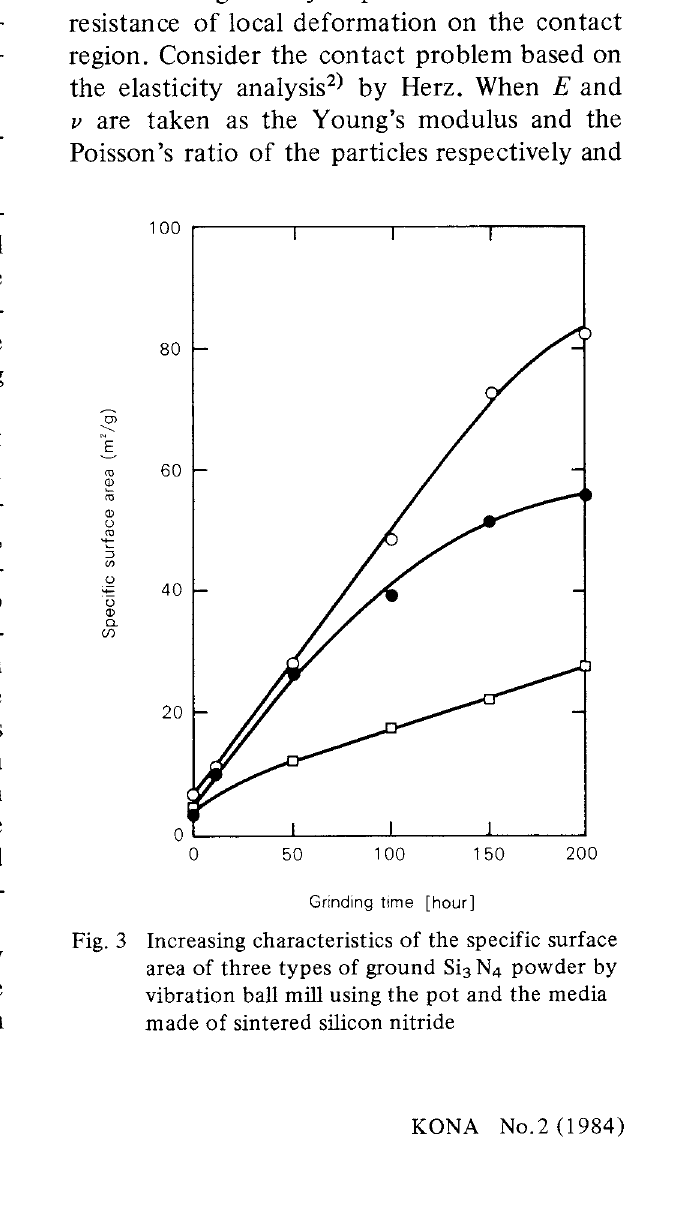
Increasing characteristics of the specific surface area of three types of ground Si 3 N 4 powder by vibration ball mill using the pot and the media made of sintered silicon